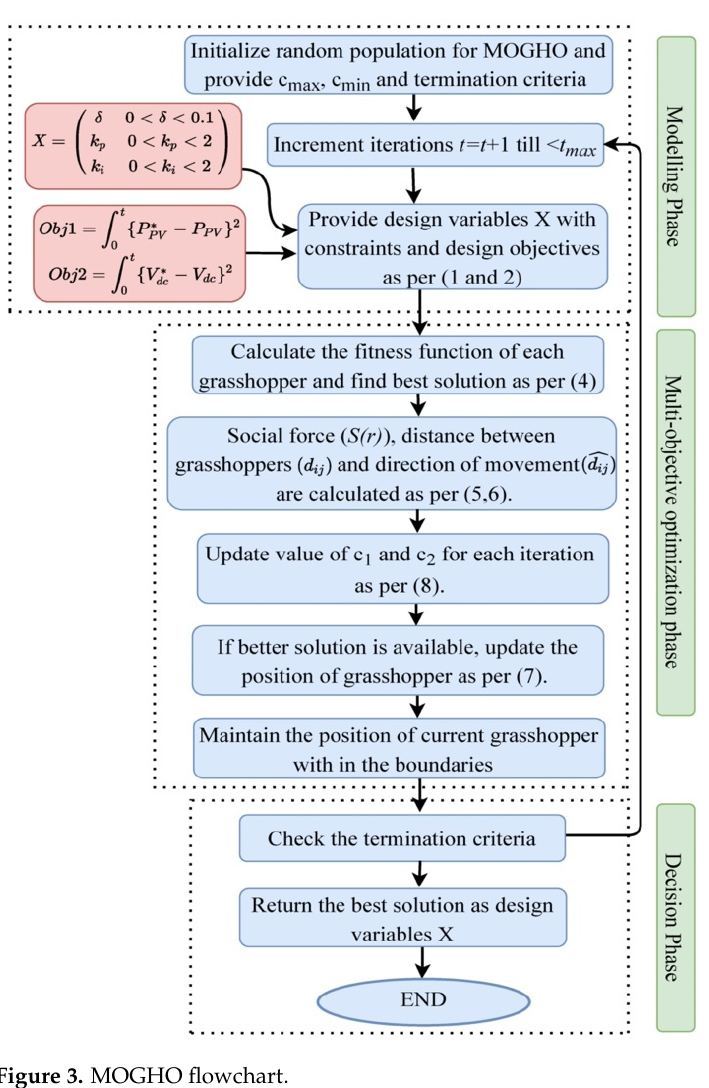
Figure 3. MOGHO flowchart. The complete equation of the MOGHO is presented as per (4).